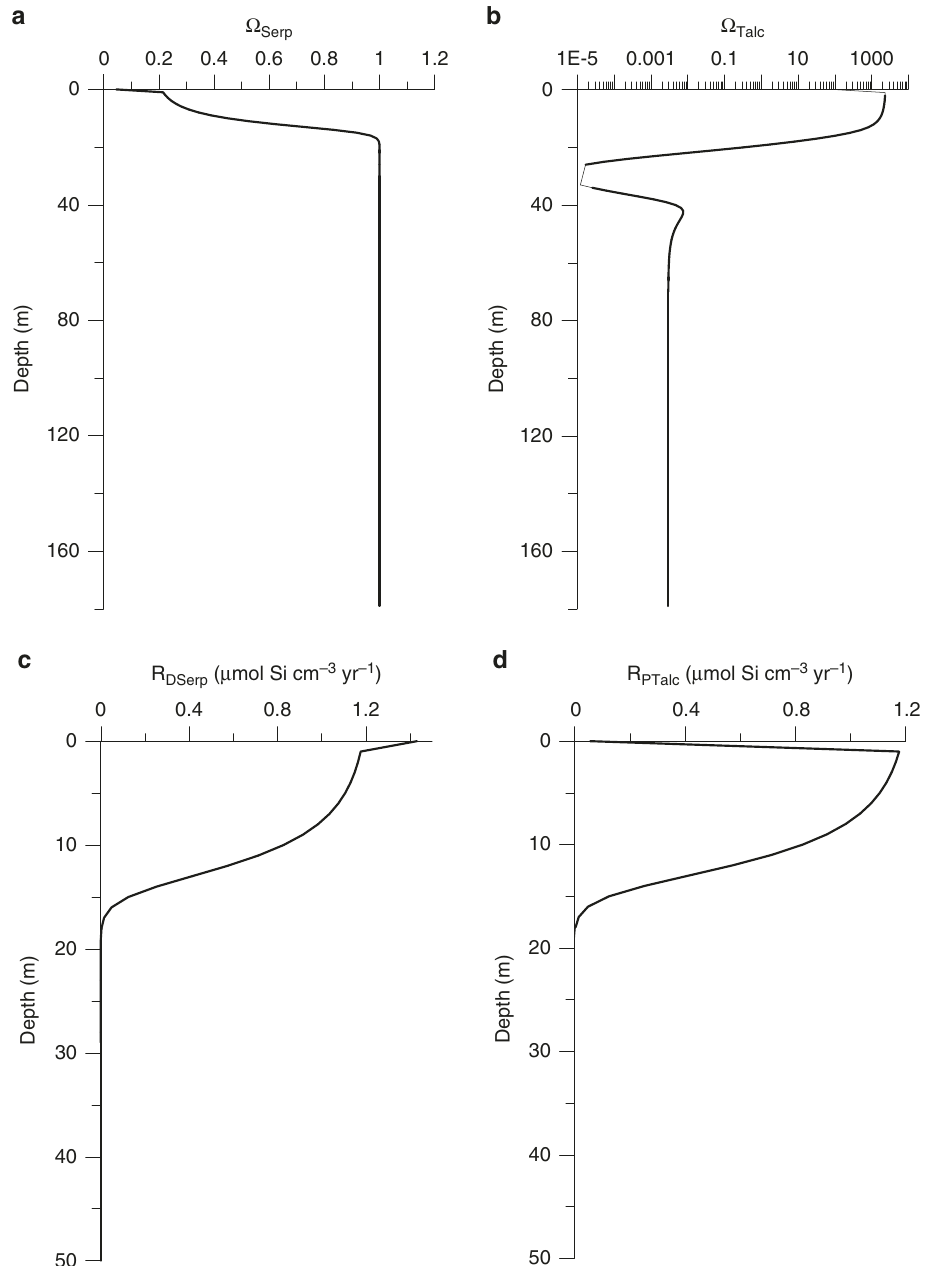
Fig. 5 Reaction rates applied in the modeling. a Saturation state of the pore fl uid with respect to serpentine, ( b ) saturation state of the pore fl uid with respect to talc. Saturation states were calculated applying measured pH values and Mg 2 + concentrations (Fig. 3) and modeled silica concentrations (Fig. 6). c Rate of serpentine dissolution, ( d ) rate of talc precipitation. Note the different depth scale in c and d